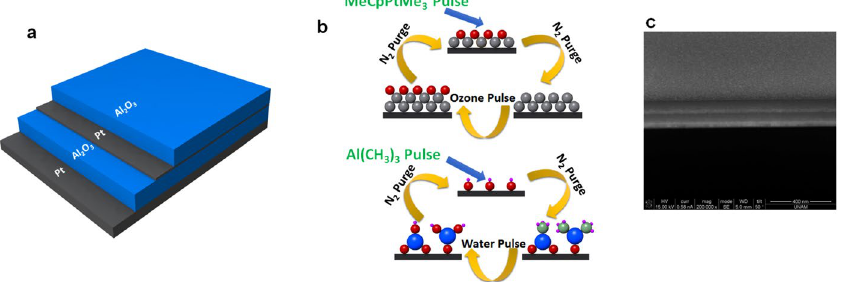
Figure 1. Schematic illustration of ( a ) proposed Pt-Al 2 O 3 MIMI structure, ( b ) the corresponding single ALD cycle to deposit Alumina and Platinum layers, and ( c ) cross sectional SEM image of fabricated planar multilayer